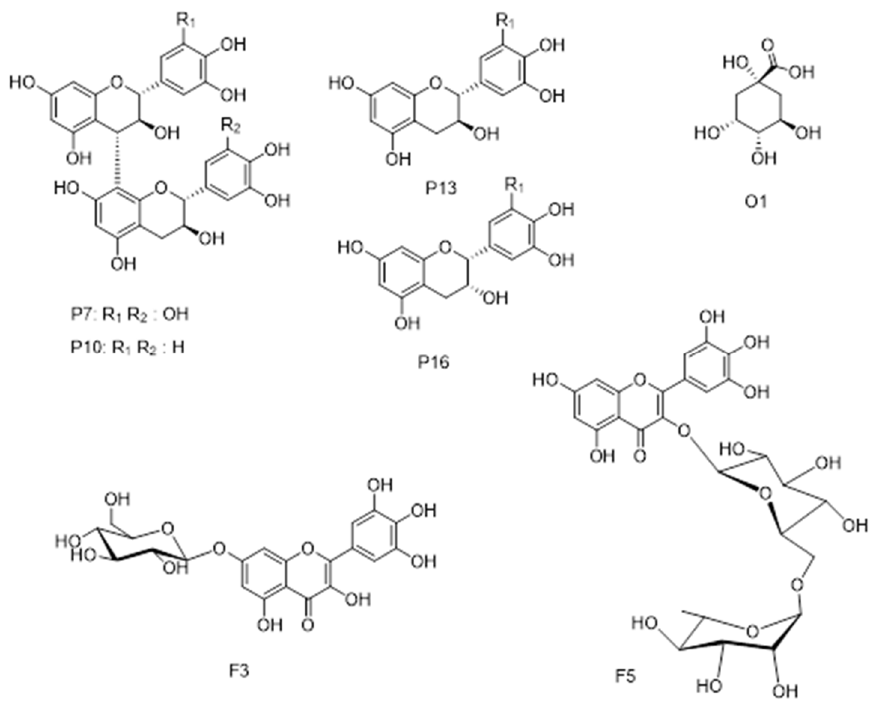
Figure 7. Main components in P. kotschyi extracts.